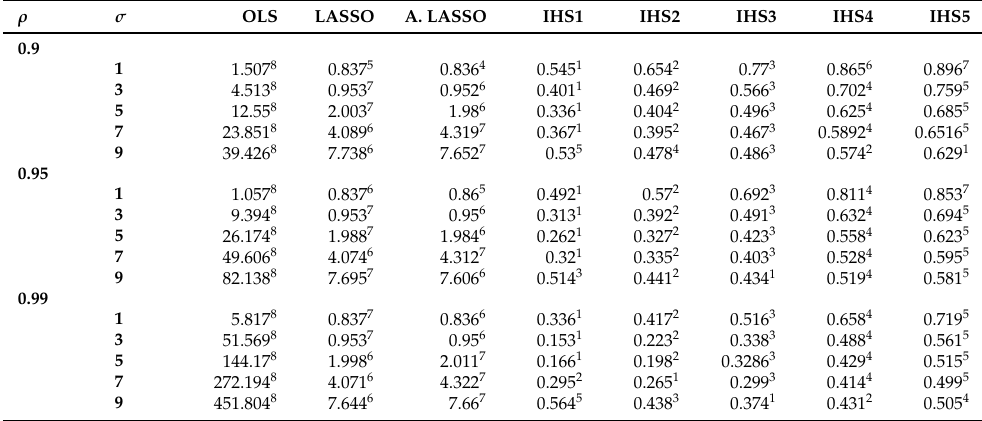
Table 1. Estimated MSEs for n = 50 and p = 4 (superscript represents ranking).